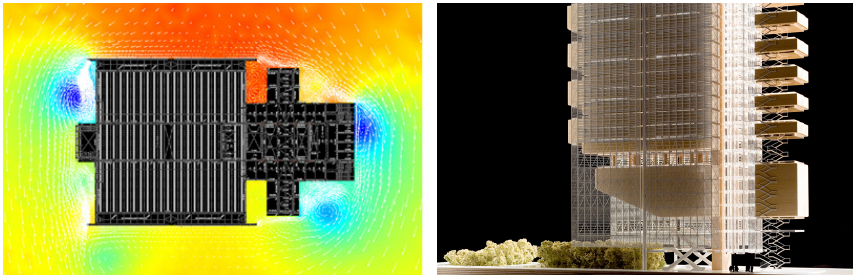
Figure 10: Wind pressure chart. - Figure 11: Study